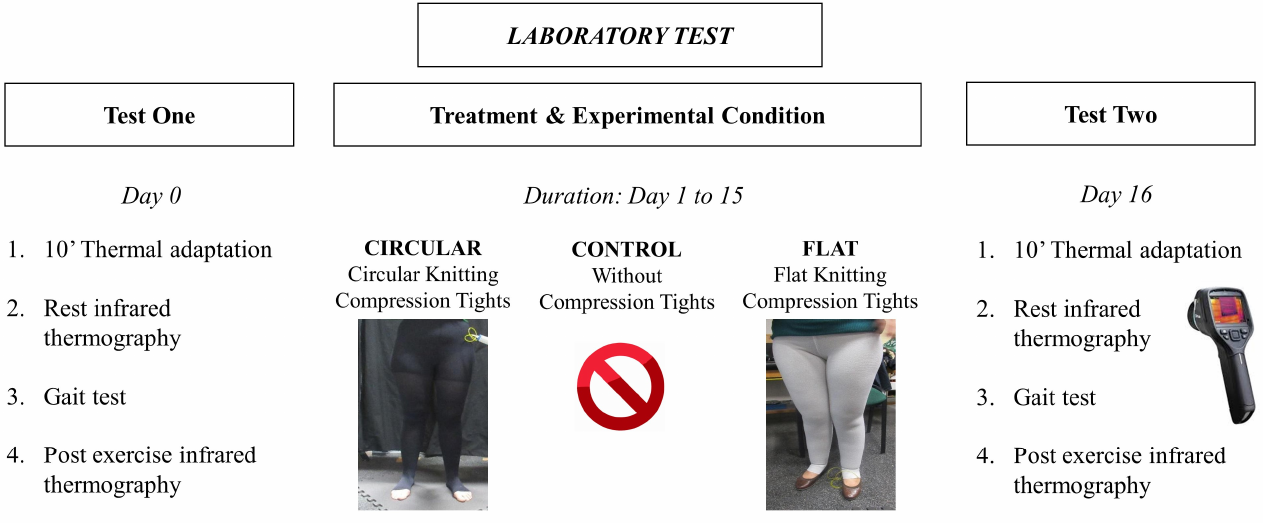
Figure 1. Study experimental design: periods and test protocol.